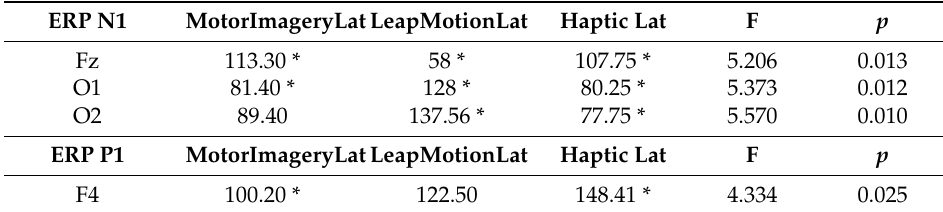
Table 1. ANOVA results and post hoc analysis with mean of latencies (ms). ERP